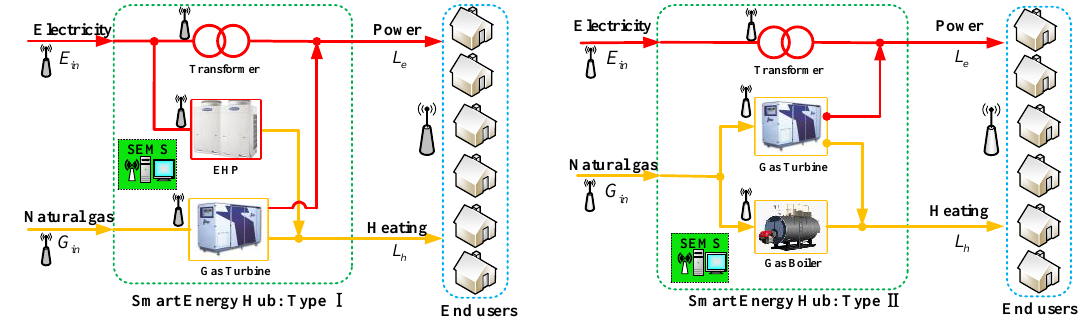
Figure 1. Two typical types of smart energy hub.